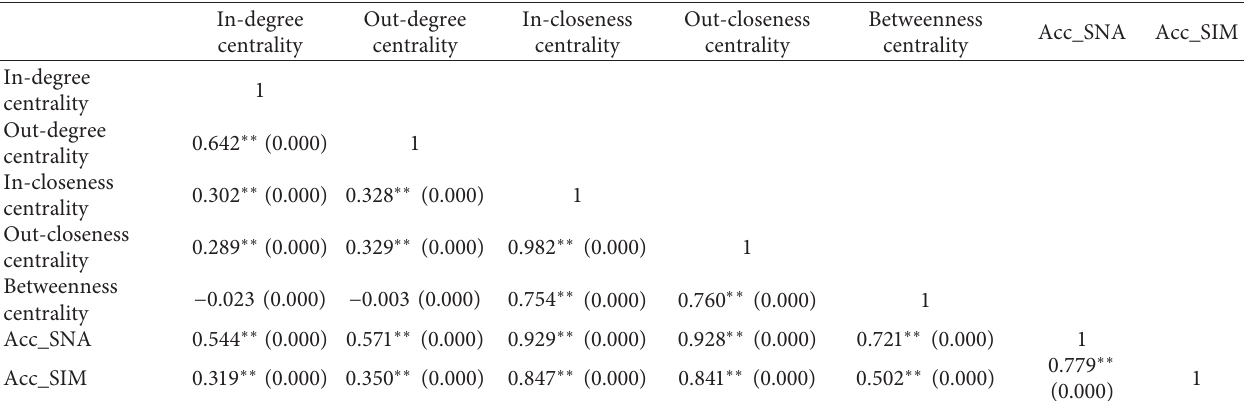
Table 2: Correlation matrix of accessibility measures.